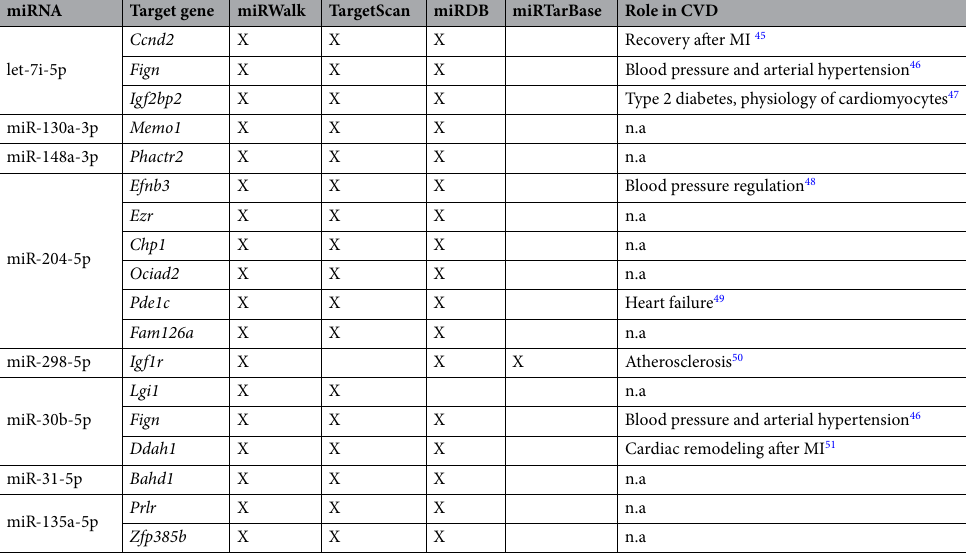
Table 3. Potential mRNA targets of candidate miRNAs within the AGAT metabolism. The analysis was performed using the online tools miRDB, miRWalk, TargetScan, and miRTarBase. For the individual databases, interactions were considered relevant when the following criteria were met: miRDB – target prediction score > 80; miRWalk – binding p-value > 0.9; TargetScan – conserved sites; miRTarBase – experimentally validated targets. All interactions which were predicted in at least three out of four of the online tools are listed in the table. CVD: cardiovascular disease; MI: myocardial infarction; n.a.: not applicable (no association with CVD